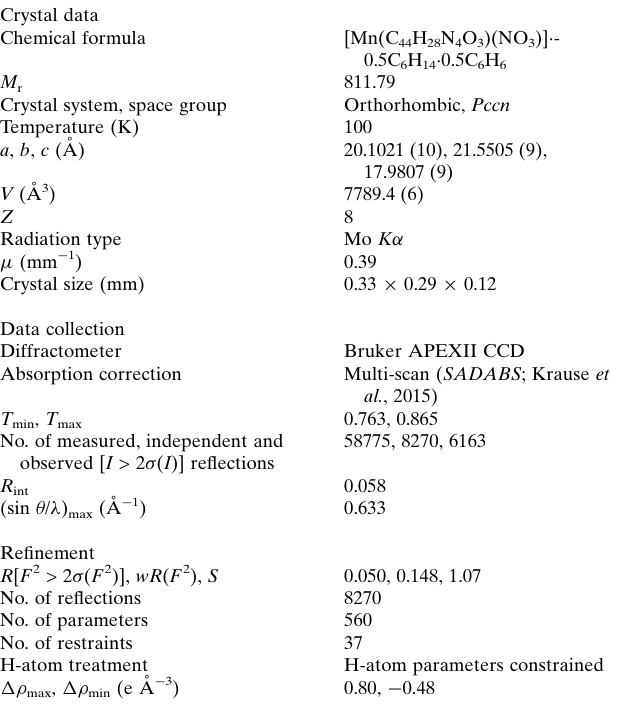
Table 3 Experimental details. Crystal data Chemical